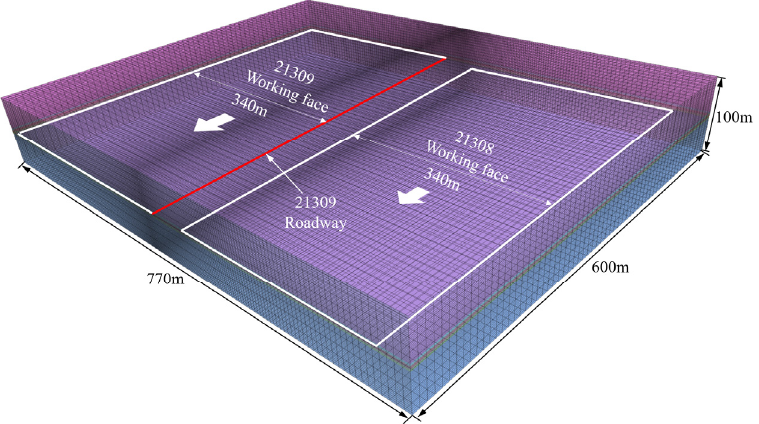
Figure 7. Numerical model.